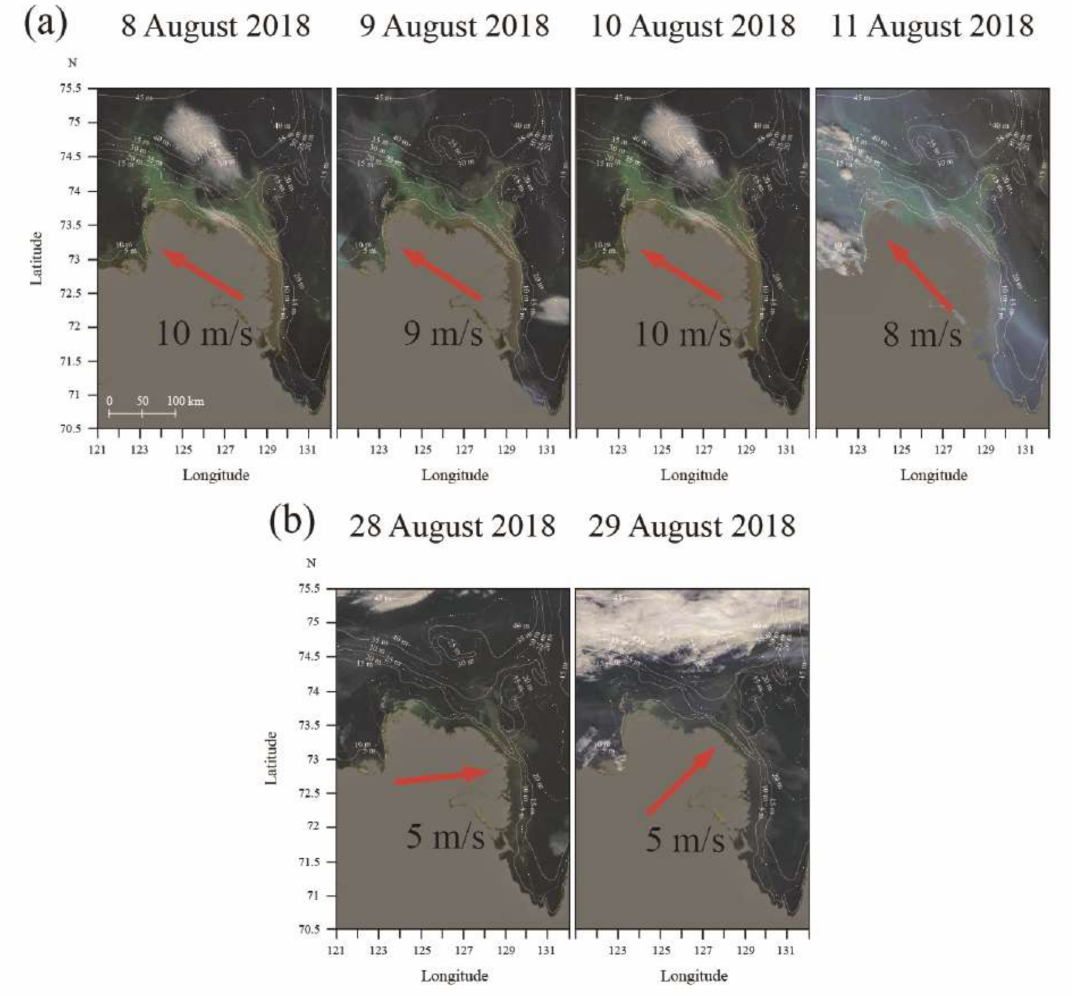
Figure 5. Corrected reflectance from MODIS Terra and MODIS Aqua satellite images of the area adjacent to the Lena Delta acquired on ( a ) 8–11 August 2018, and ( b ) 28–29 August 2018 and wind forcing (arrows) during upwelling ( a ) and non-upwelling ( b )